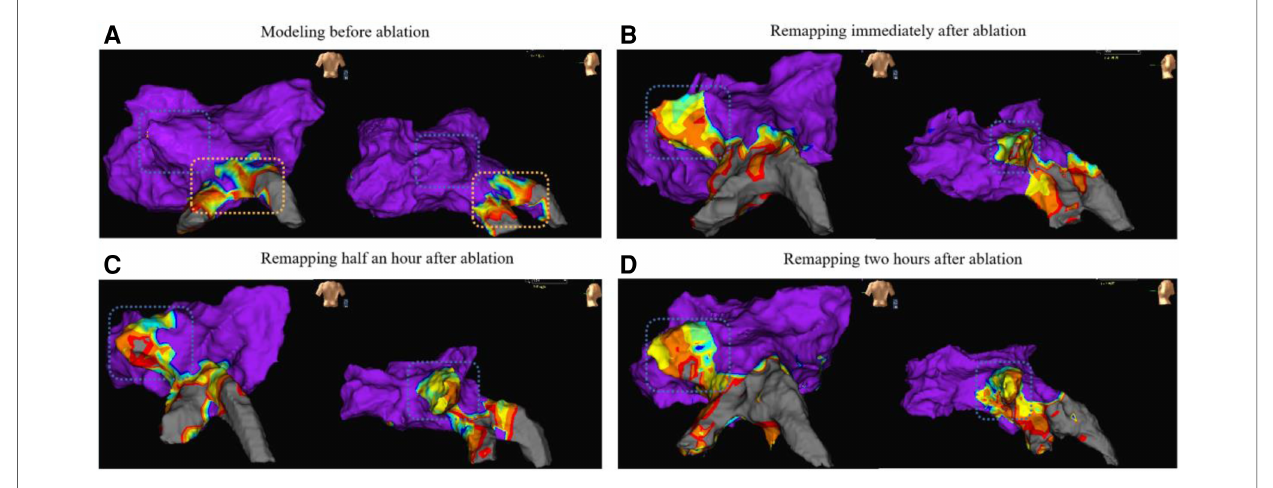
FIGURE 5 The remapping results (from dog A5) of the voltage maps are presented in anterior-posterior view (left side of each map) and left-anterior oblique view (right side of each map). Map A shows the preoperative left atrial modeling, Map B shows the voltage map immediately after ablation, Map C shows the voltage map 30 min after ablation, and Map D shows the voltage map 2 h after ablation. The blue wireframe in the fi gure represents the ablation site (left superior PV). The yellow frame in Map A partially represents the left inferior PV and its branches, and preoperative mapping revealed low voltage due to the animal itself.